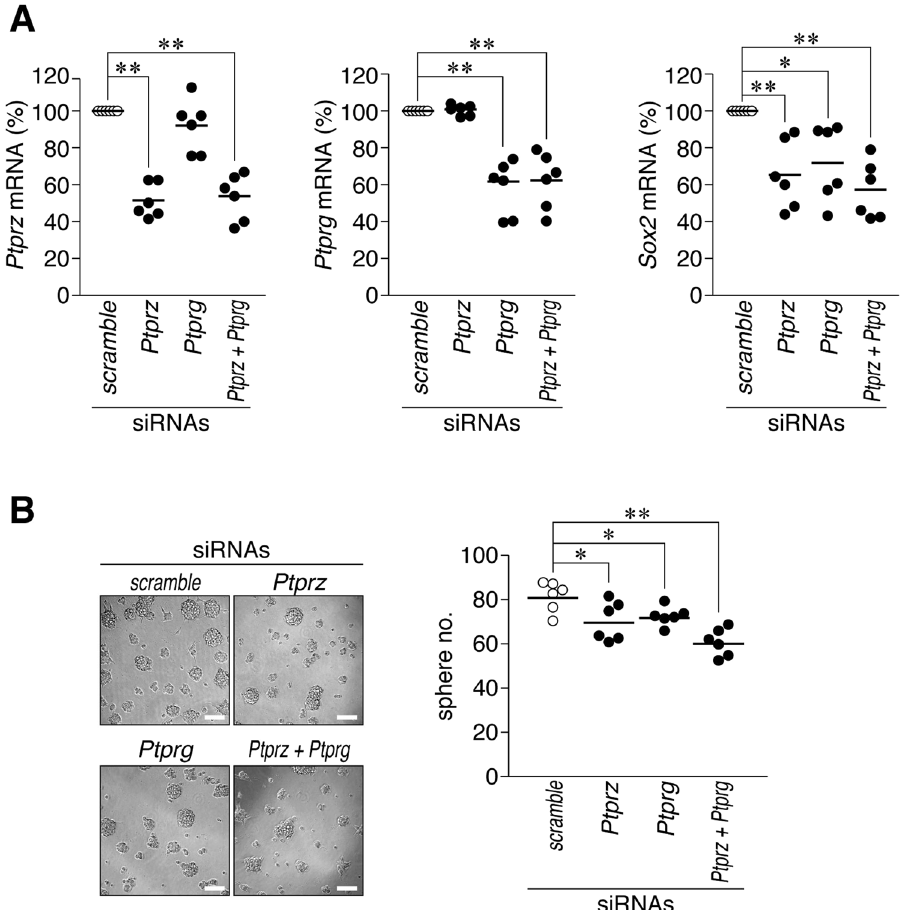
Figure 9. Effects of Ptprg knockdown on C6 stem cell-like properties. ( A ) Quantitative RT-PCR analyses. C6 cells were electroporated with short interfering RNA (siRNA) for rat Ptprz , Ptprg , or Ptprz plus Ptprg . After a 48-h culture, RNA was extracted from cells and subjected to quantitative RT-PCR. The plots show the mRNA expression of Ptprz , Ptprg , and Sox2 normalized to Gapdh expression. ( B ) Sphere formation assay. Cells transfected with the indicated siRNAs were cultured for 7 days in CSC medium. Scale bars, 100 µ m. Images are representative of six independent cultures. The plot shows sphere number per well. * P < 0.05, ** P < 0.01, significantly different from the scramble control (Student’s t